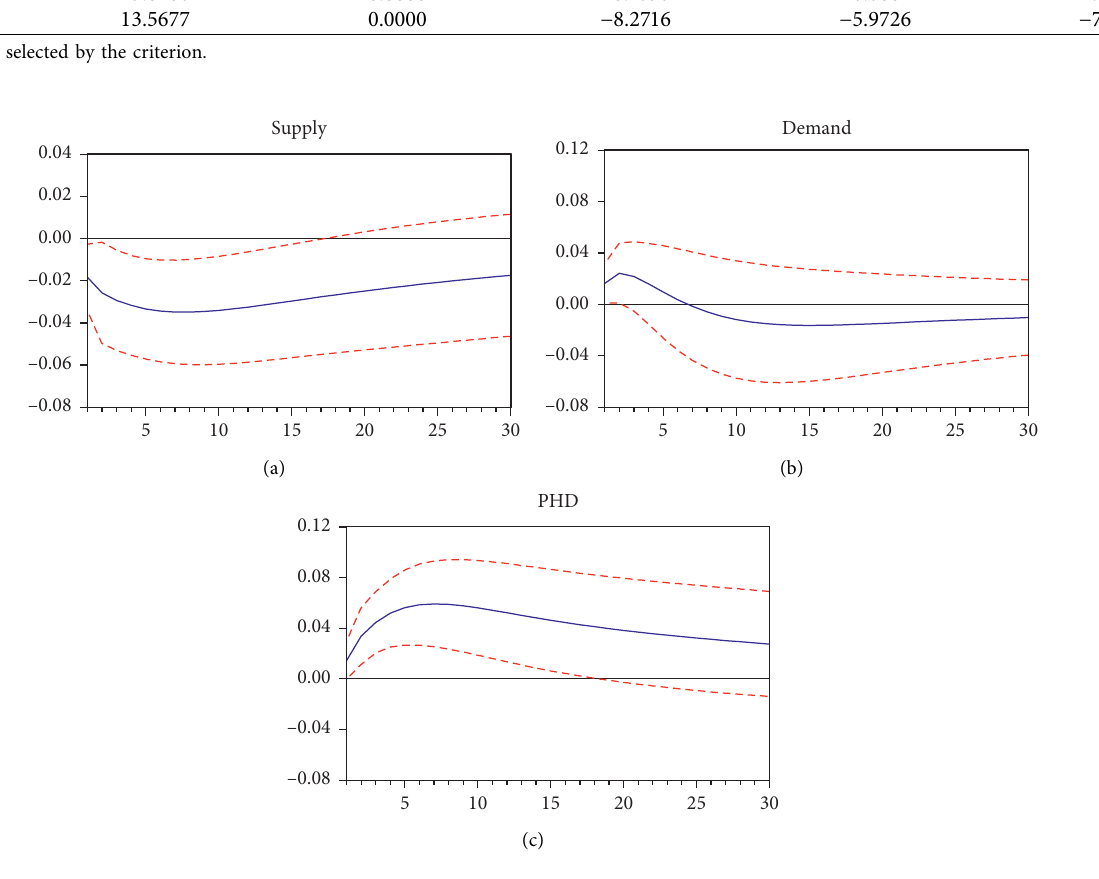
Figure 4: Responses of Brent oil prices to different shocks based on VAR P . The blue solid lines represent the mean impulse response of Brent oil prices and the red dotted lines denote two standard deviations from the mean. The response period is 30 months. (a) Response of Brent oil prices to a supply shock. (b) Response of Brent oil prices to a demand shock. (c) Response of Brent oil prices to a PHD shock. Table 6: Model forecasting results.